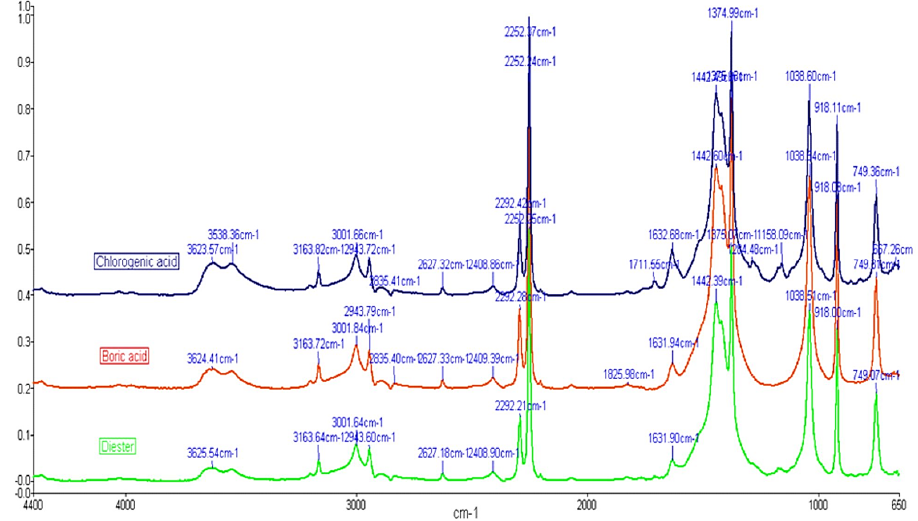
Figure 5. FTIR spectrum of 5-DCB complex, BA, and CGA (or 5-CQA). 5-CQA: 5-Caffeoylquinic acid; 5-DCB: Diester chlorogenoborate; BA: Boric acid; CGA: Chlorogenic acid; FTIR: Fourier-transform infrared (spectroscopy).